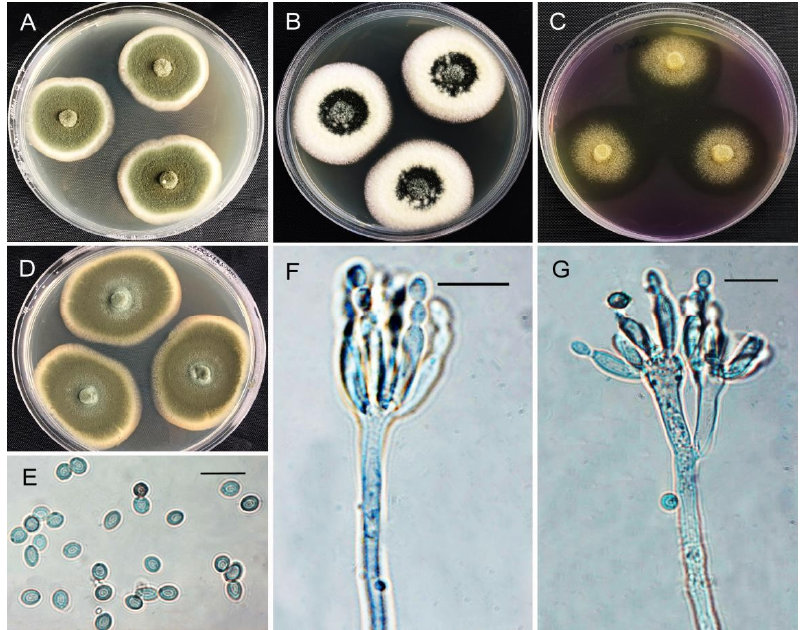
Figure 4. Penicillium oxalicum isolate HZ06. ( A ) Colonies on CYA after 7 days at 25 °C. ( B ) Colonies on MEA after 7 days at 25 °C. ( C ) Colonies on CREA after 7 days at 25 °C. ( D ) Colonies on CYA after 7 days at 37 °C. ( E ) Conidia. ( F , G ) Conidiophores. Scale bar = 10 μ m.